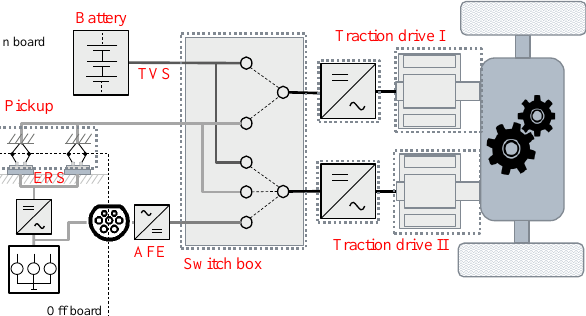
Figure 1. Schematic view of a powertrain with fully integrated ERS energy transfer (FIETS), utilising its machines as isolation transformer [9]. The thick dashed line indicates components that need double isolation.